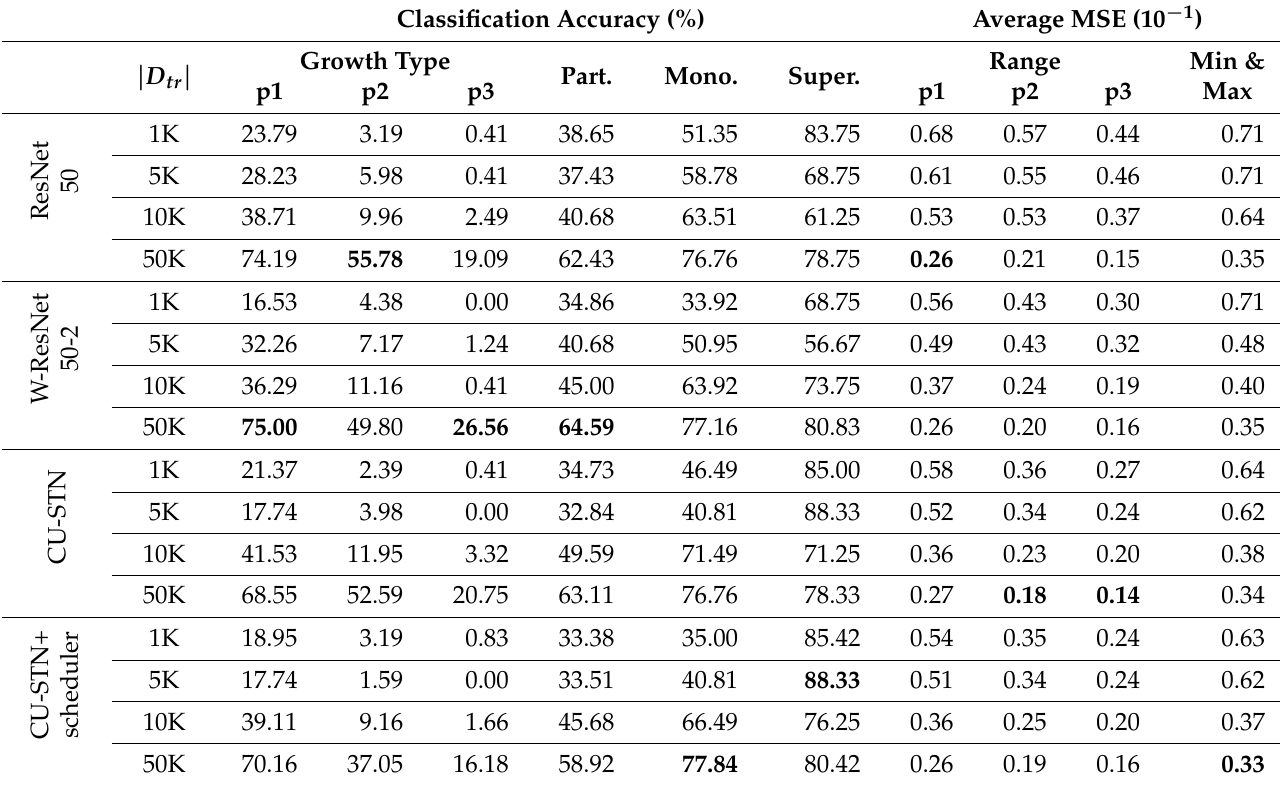
Table 7. Performance of all subtasks with the synthetic test data (500 samples; part., the number of partitions; mono., monotonicity; super., superiority; | D tr | , size of training and validation data, W-ResNet-50-2: